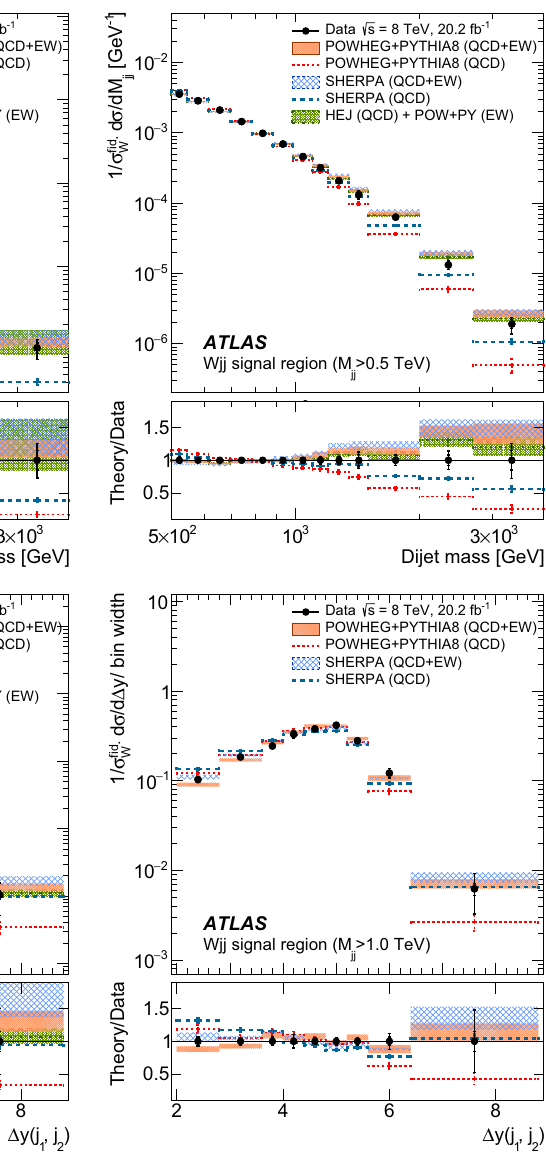
M jj > 0 . 5 TeV ( left ) and M jj > 1 . 0 TeV ( right ). Both statistical ( inner bar ) and total ( outer bar ) measurement uncertainties are shown, as well as ratios of the theoretical predictions to the data (the bottom panel in each